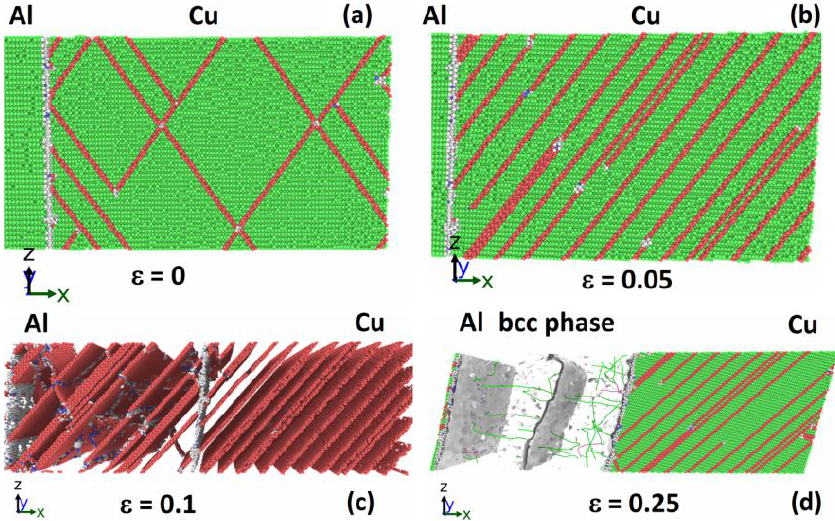
Figure 18. Plastic deformation of Al-Cu composite with the (110) interface at the initial pressure of 40 GPa: ( a ) twins in Cu are formed during the initial relaxation; ( b ) increase in the number of twinning layers in Cu with shear; ( c ) stacking faults fill both parts of the system; ( d ) formation of BCC phase with subgrains in Al.